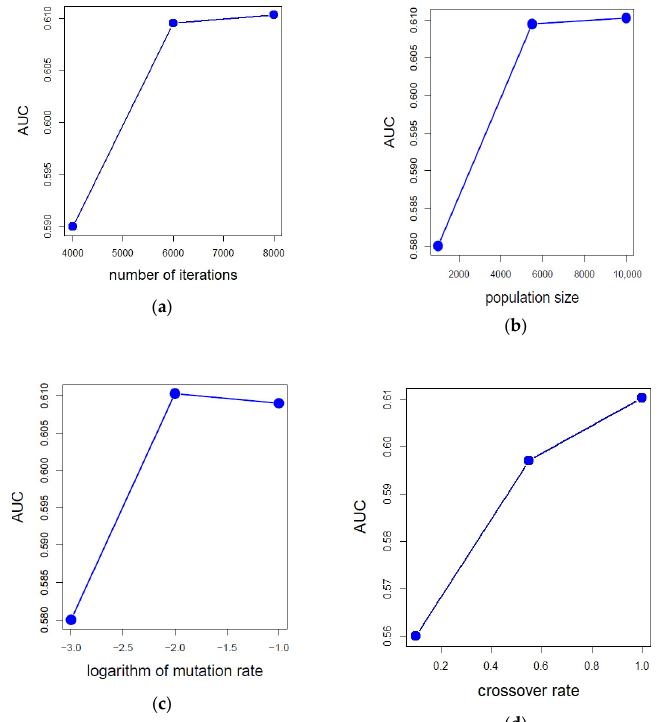
Figure 2. Main effects plots of: ( a ) number of iterations; ( b ) population size; ( c ) logarithm of muta- tion rate; ( d ) crossover rate. rate; ( d ) crossover